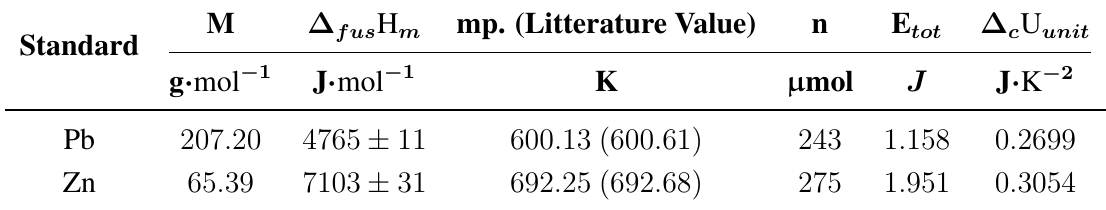
Table 3. The calibration standards with corresponding physical properties and experimental unit energies ( ∆ U ) are presented. The ∆ c unit Grønvold [62] and the litterature values for the melting point onset (mp.) from Ditmars (Zn) and Zahra & Zahra (Pb)